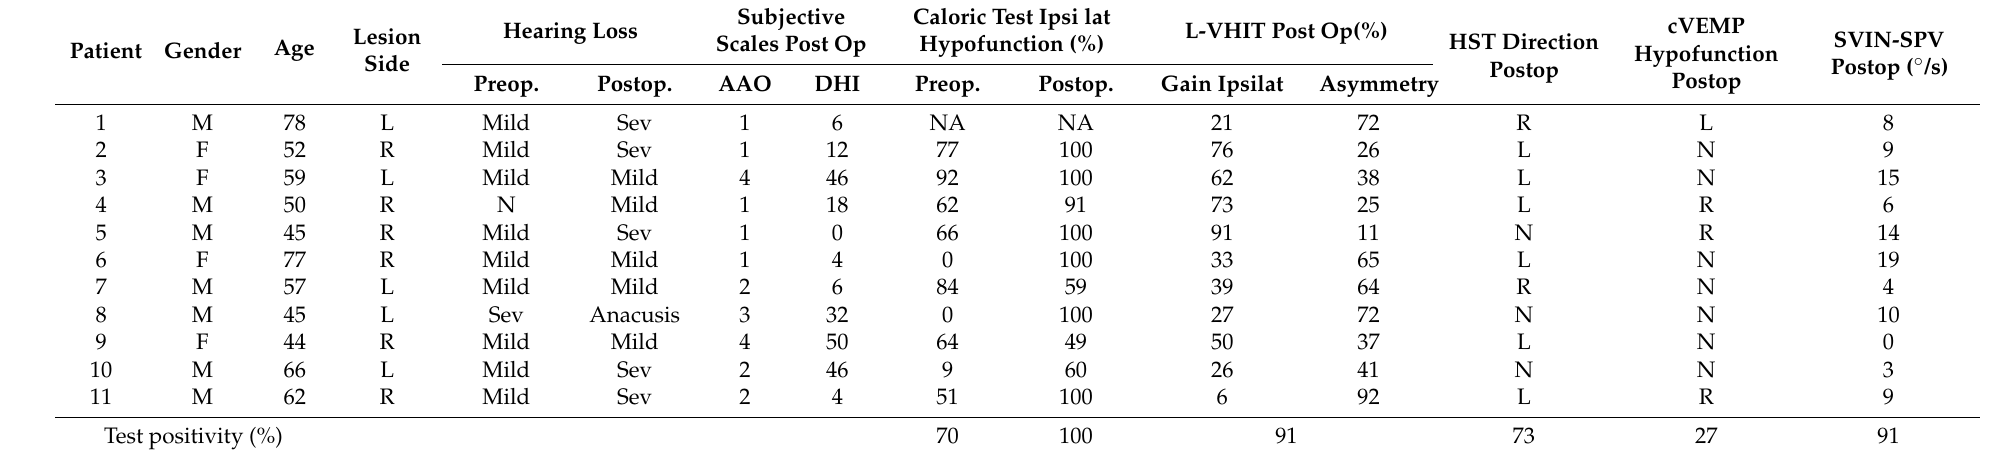
Table 1. Population. Audiological and Vestibular Results. Subjective Scales